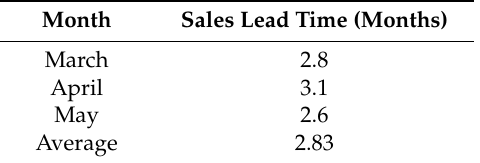
Table 10. The sales lead time (March 2016 to May